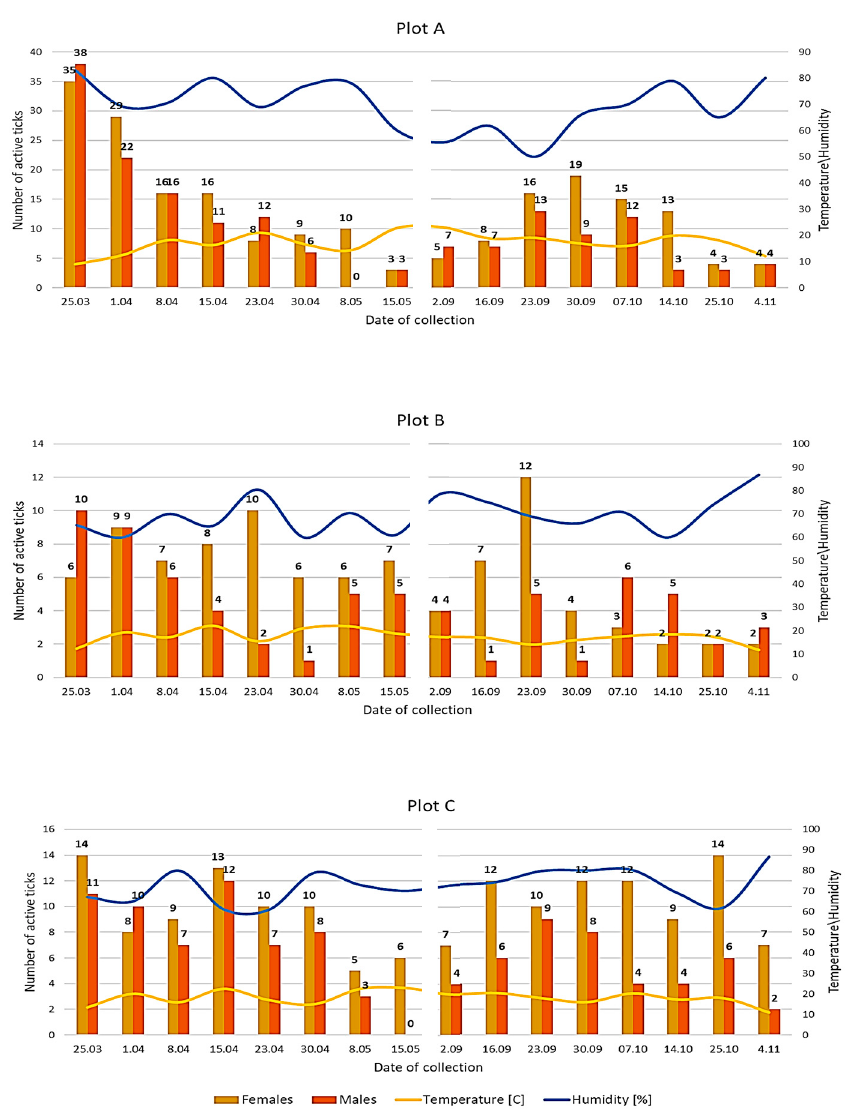
Figure 3. Number of active Dermacentor reticulatus adults in context of temperature and relative humidity in the analysed localities in eastern Poland (2019).